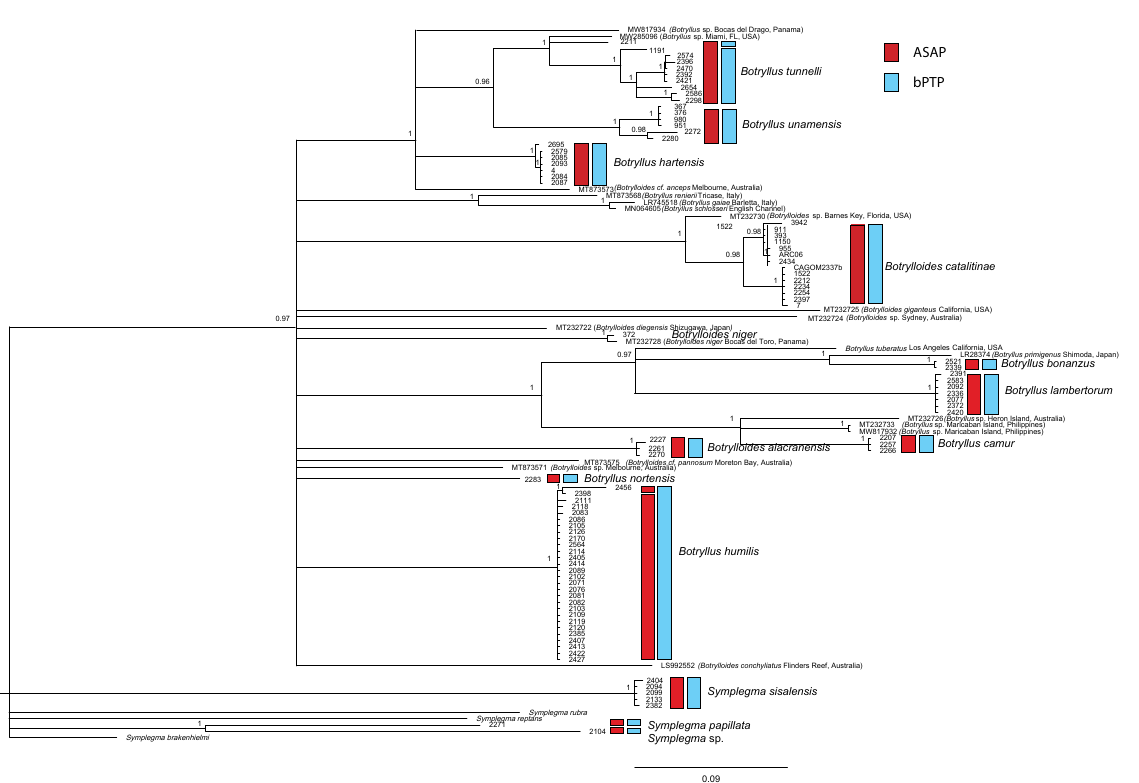
Figure 17. Bayesian phylogenetic tree of samples collected as part of this study, as well as related Botrylloides and Botryllus sequences available on GenBank. The red bars denote species recovered by the ASAP species delimitation method. The blue bars denote species recovered by the bPTP species delimitation